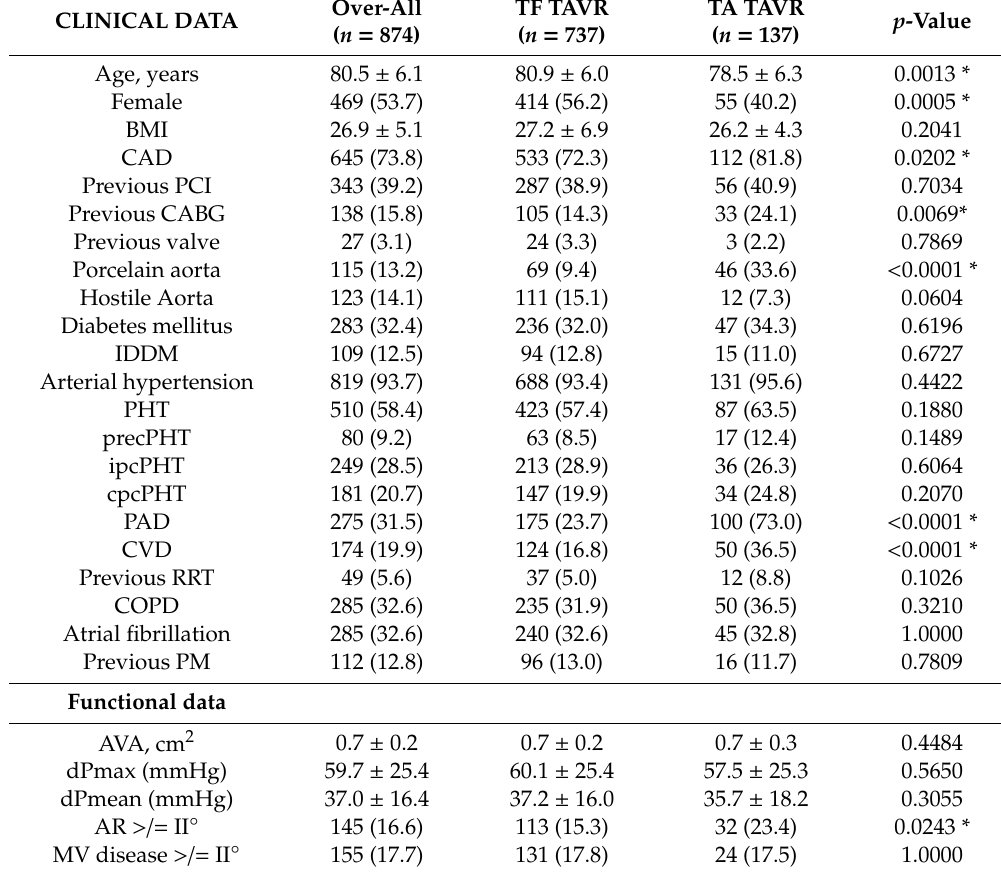
Table A1. Patient Clinical and Functional